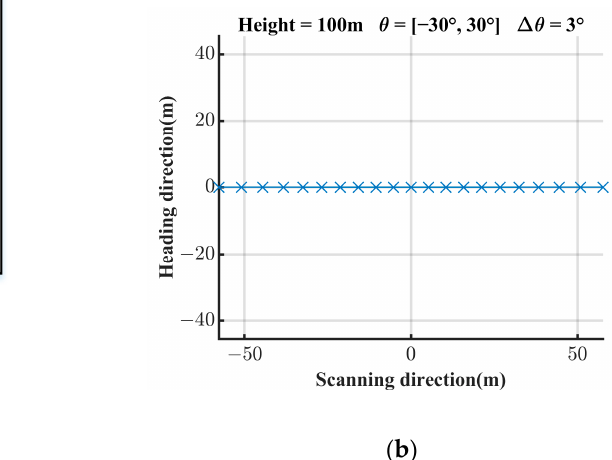
Figure 7. Quadrangular tower mirror scanning mode 2. ( a ) Scanning schematic diagram; ( b ) Scan- ning track with a height of 100 m, a motor rotation angle of ±30° , and an interval angle of 3° be- track with a height of 100 m, a motor rotation angle of ± 30 ◦ and an interval angle of 3 ◦ between tween points.